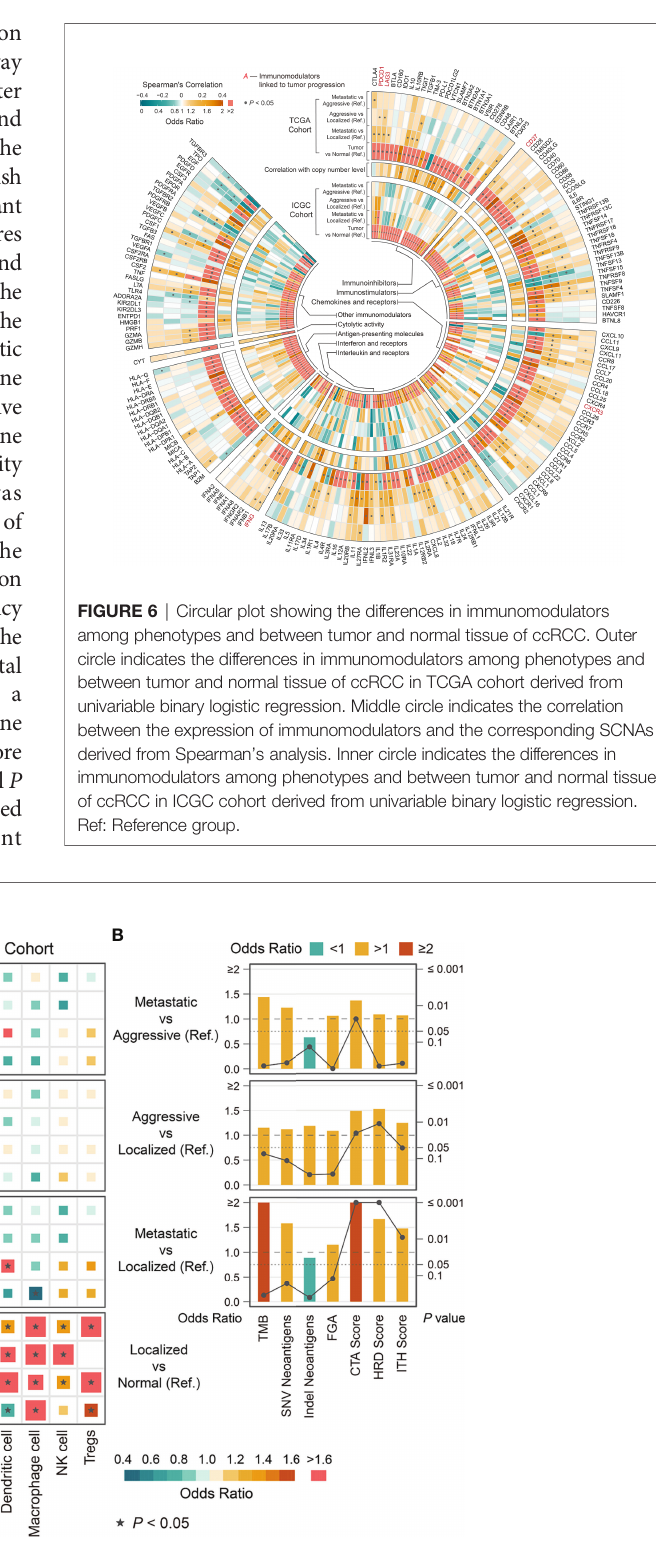
FIGURE 5 | The differences in immune cells and immunogenicity indicators among phenotypes of ccRCC derived from binary logistic regression. (A) The differences in immune cells among phenotypes of ccRCC in TCGA and ICGC cohort. (B) The differences in immunogenicity indicators among phenotypes of ccRCC in TCGA cohort. Ref: Reference